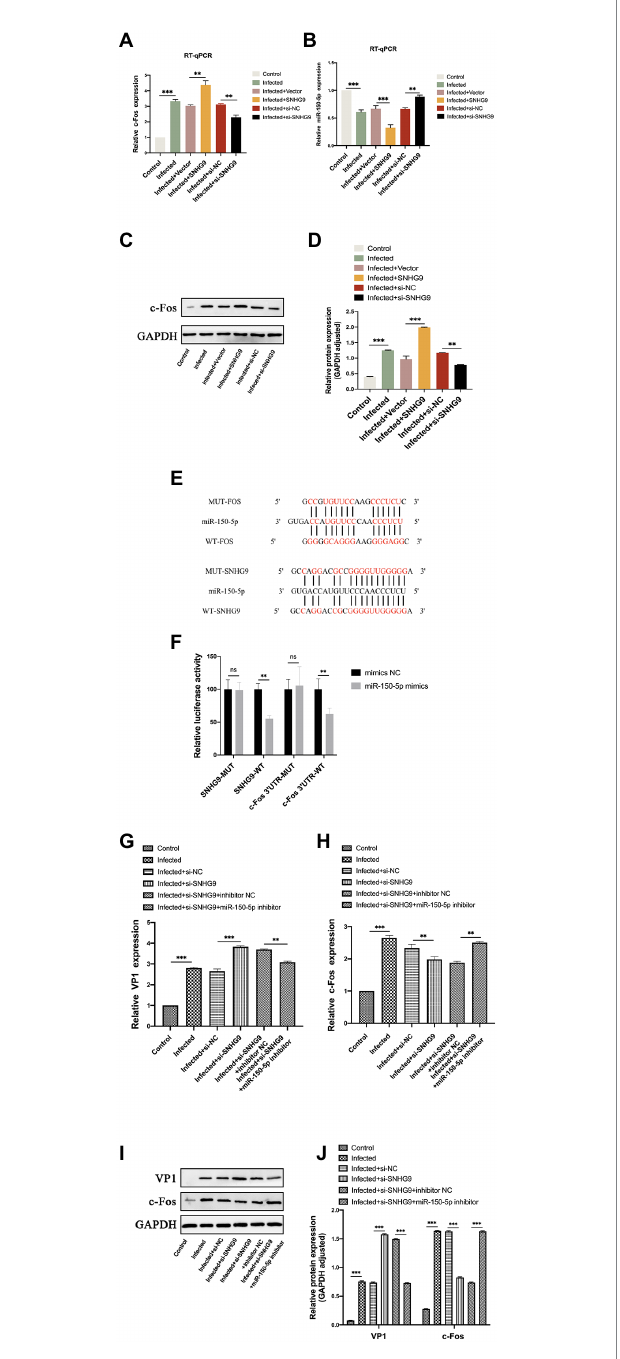
FIGURE 8 SNHG9 regulates viral replication during EV-D68 infection of RD cells via the miR-150-5p/c-Fos axis. RD cells were transfected with SNHG9- overexpression plasmid or si-SNHG9 and then infected with EV-D68 for 12 h. (A,B) The expression of miR-150-5p and c-Fos in RD cells was detected by qRT-PCR (** p < 0.01, *** p < 0.001). (C,D) Western blot was utilized to evaluate viral c-Fos protein levels. The data are expressed as mean ± SD ( n = 3) * p < 0.05, ** p < 0.01, and *** p < 0.001 vs. the control, vector, and si-NC groups. (E) The binding sites for miR-150-5p in the SNHG9/c-Fos sequence were shown. (F) The interaction between miR-150-5p and SNHG9/c-Fos was verified by a dual luciferase reporter assay. RD cells were transfected with si-SNHG9 or conjugated with miR-150-5p inhibitor, and then infected with EV-D68 for 12 h. (G,H) Detection of viral VP1 and c-Fos expression in RD cells by qRT- PCR. (I,J) The protein levels of c-Fos and VP1 in RD cells were evaluated by western blot assay. Data are expressed as mean ± SD ( n = 3). * p < 0.05, ** p < 0.01, *** p < 0.001 vs. the indicated